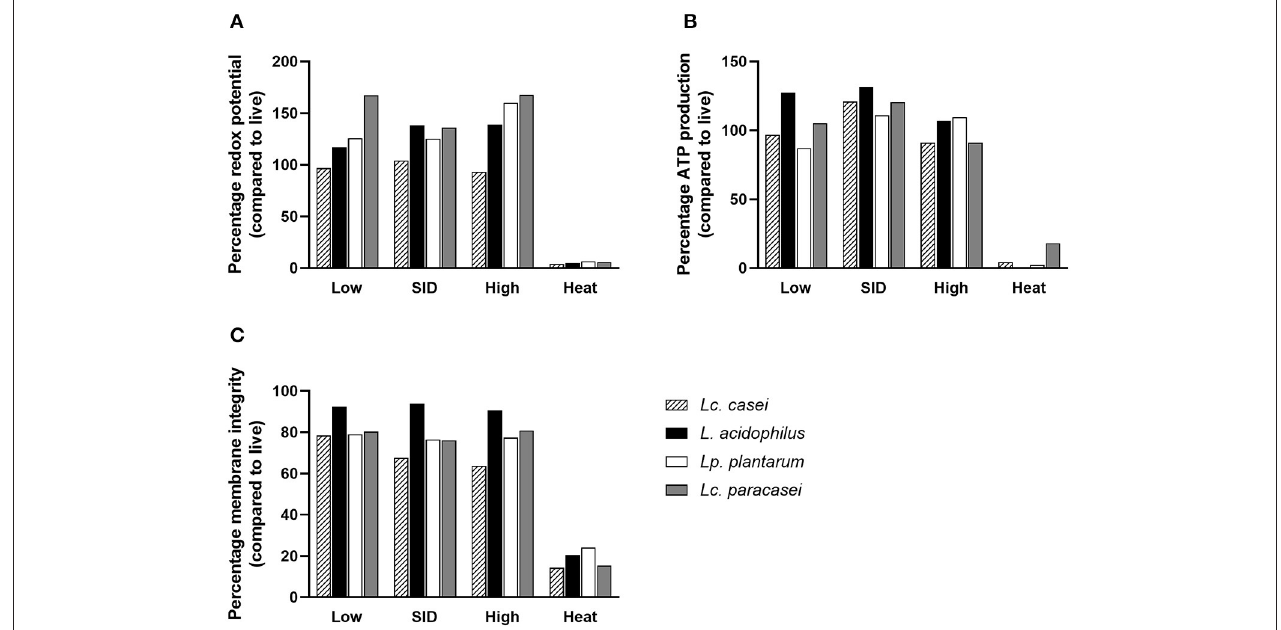
FIGURE 2 | Metabolic activity and membrane integrity. Percentages of redox potential (A) , ATP production (B) , and membrane integrity (C) of irradiated and heat-inactivated Lacticaseibacillus casei (pattern-filled), Lactobacillus acidophilus (black), Lactiplantibacillus plantarum (white), and Lacticaseibacillus paracasei (gray) compared to live bacteria are shown. Mean values derived from triplicates are shown in each graph. Irradiation doses: low (3,000Gy), SID (variable doses according to the strain), high (10,000Gy); heat treatment: 95 ◦ C,